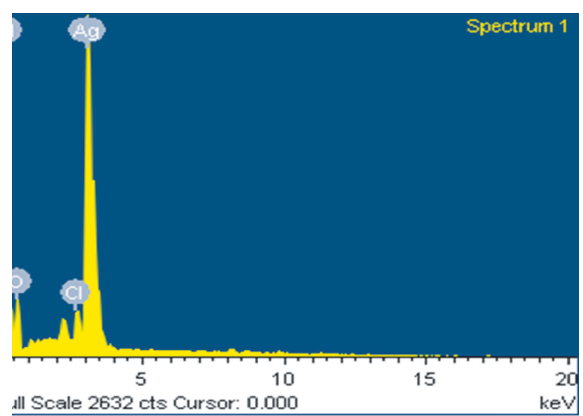
Figure 5: EDAX spectrum of synthesized silver nanoparticles using the Pisonia Alba leaf